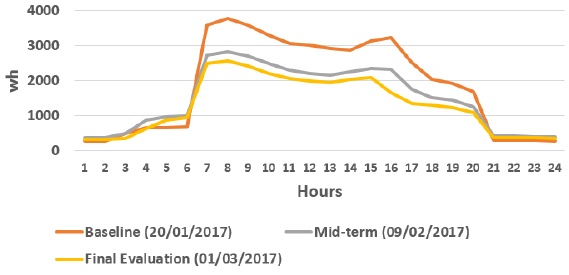
Figure 16. Office 4 energy consumption in Baseline Period, Mid-term evaluation and in Final evaluation.